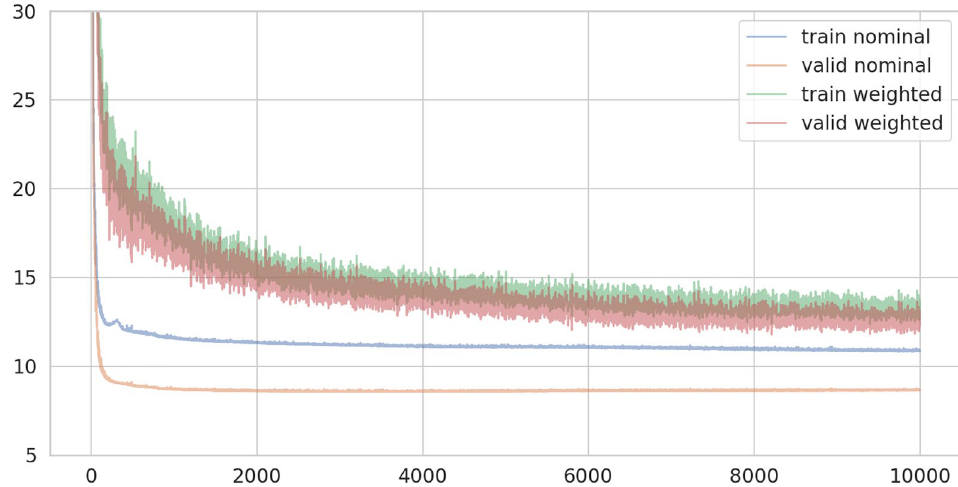
Figure 3. History of the loss function in the 10,000 epochs of the training.